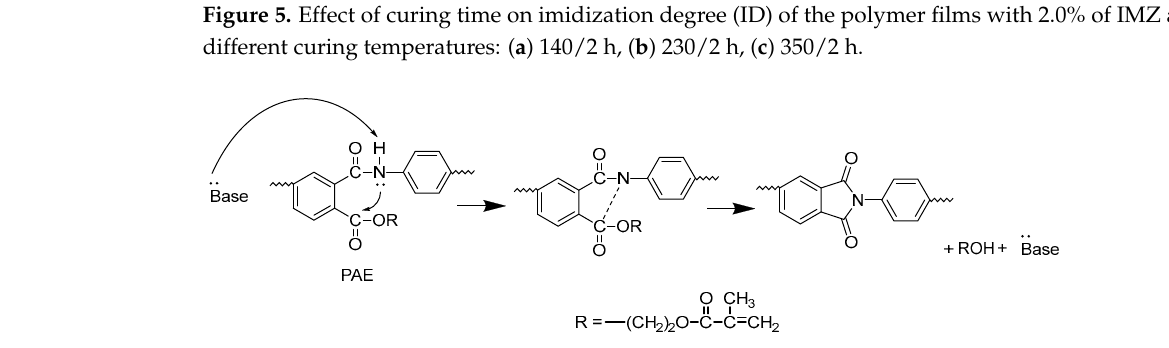
Scheme 2. Mechanism of the low-temperature imidization of PAE catalyzed by heteroaromatic ba- ses.